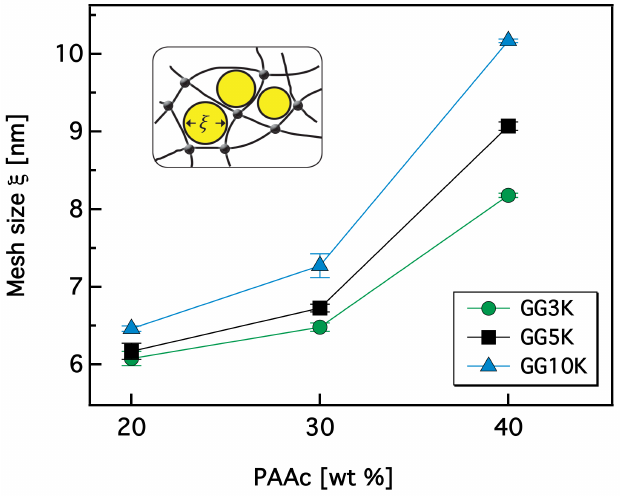
Figure 7. Correlation of the mesh size estimated from rheological data with the PAAc content of hydrogels in deionised water